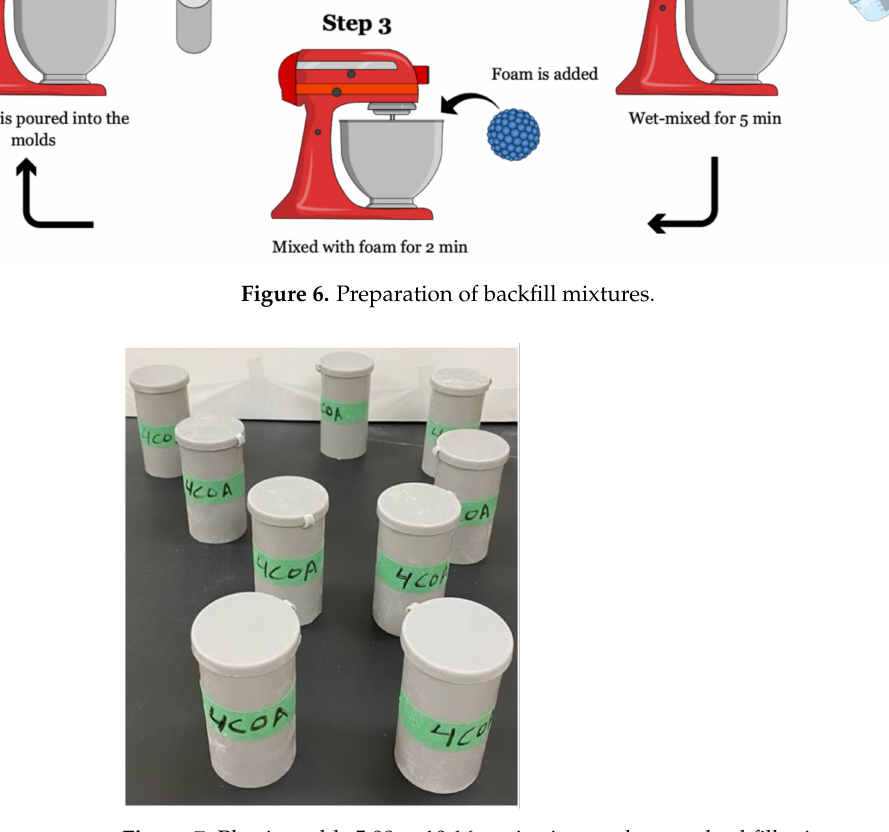
Figure 7. Plastic molds 5.08 × 10.16 cm in size used to cast backfill mixtures. For UCS testing, the prepared mixtures (Table 5) were cured for 7, 14, or 28 days in a curing room. Samples for fresh density testing were not cured and those for dry density testing were cured for 28 days. The curing room is capable of curing backfill specimens under preset temperature of 25 ± 2 ◦ C and relative humidity of 90 ± 2%. These settings were used to simulate underground